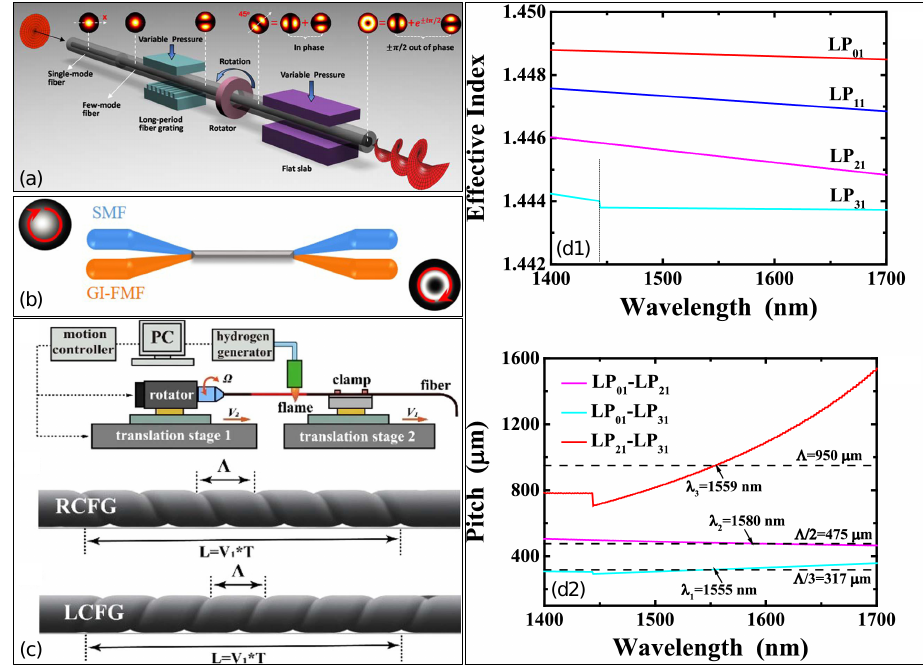
Figure 18. All-fiber OAM mode generators. ( a ) Principle of the controllable all-fiber OAM beam generator based on mechanical long-period grating. Adapted with permission from Ref. [23] © The Optical Society. ( b ) Schematic of the all-fiber mode selective coupler. Adapted with permission from Ref. [22] © The Optical Society. ( c ) Schematic of the helical fiber grating fabrication setup using a hydrogen-oxygen flame, and the periodic helical structures of right-handed chiral and left-handed chiral gratings. Adapted with permission from Ref. [26] © The Optical Society. ( d1 ) n eff of LP modes in a four-mode fiber. ( d2 ) The resonant pitches of a helical fiber grating versus the wavelength. Adapted with permission from Ref. [27] © The Optical